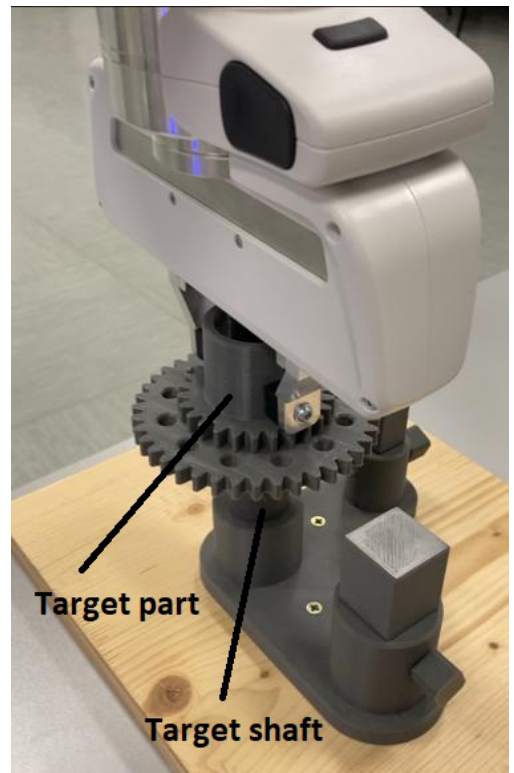
Figure 11. Experimental assembly task, including the Franka EMIKA panda manipulator and the target gear to be installed.